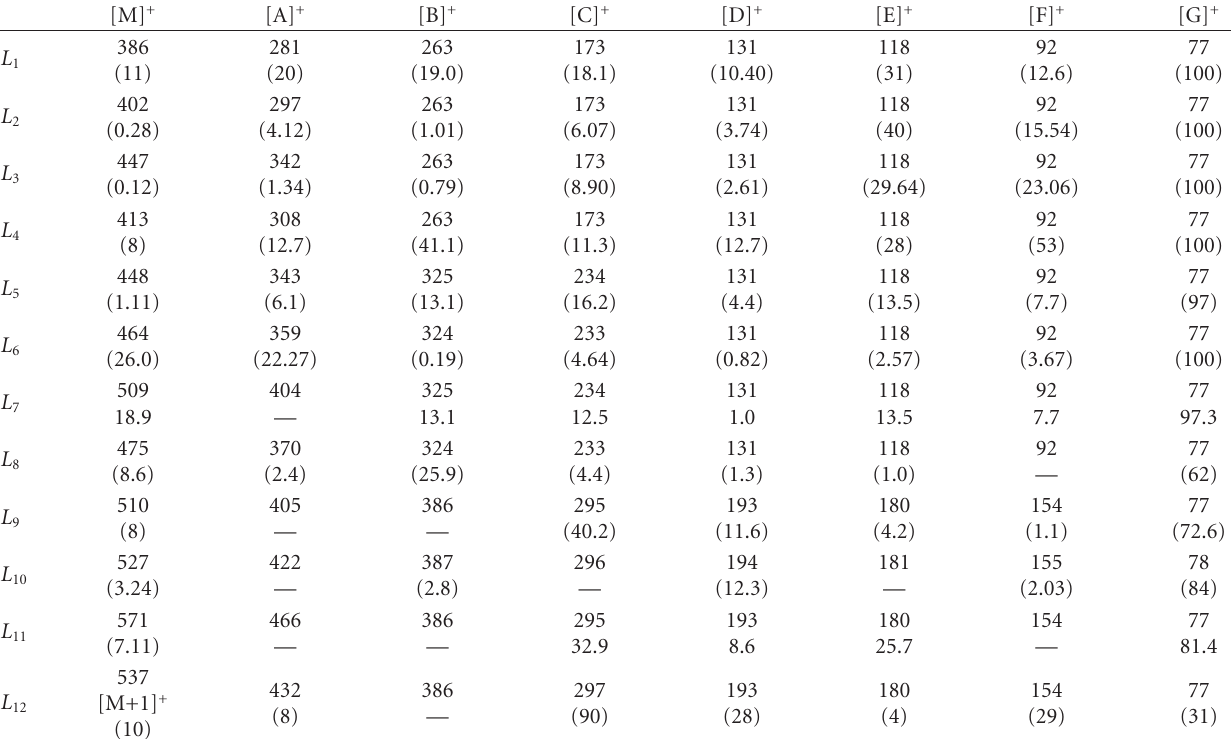
Table 4: m/z values (relative intensities) of the main fragments of the